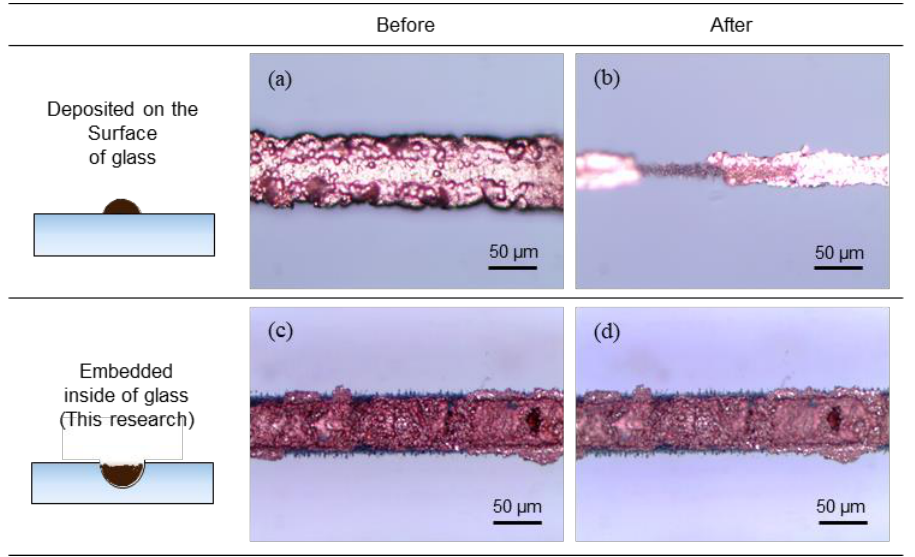
Table 3. Surface roughness and detection of Cu for each area of glass analyzed.